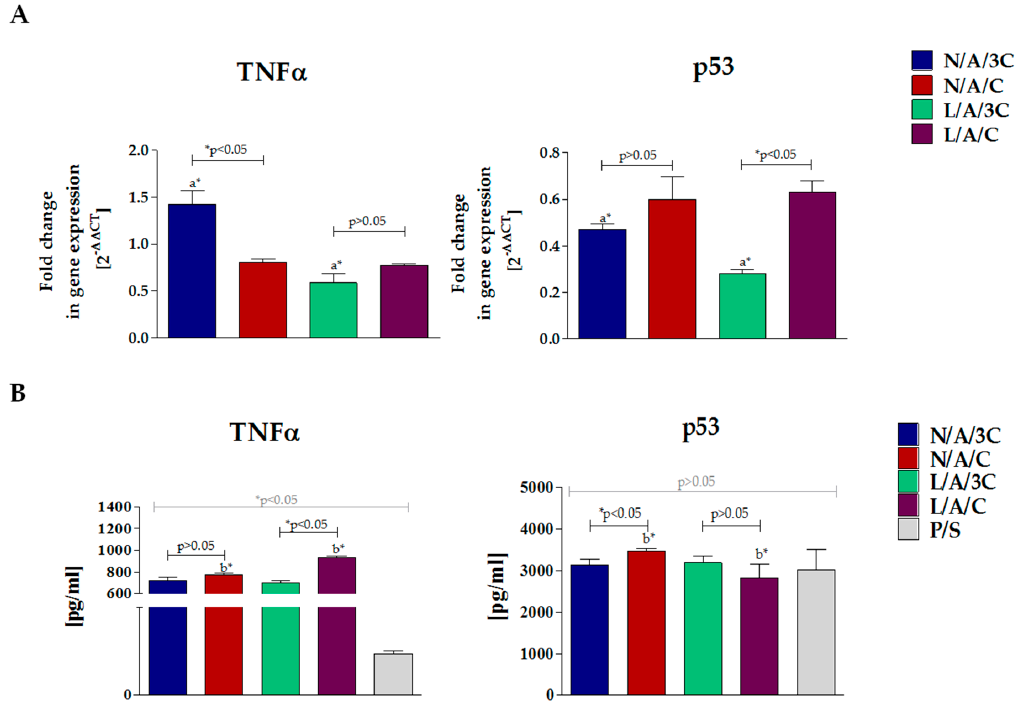
Figure 10. ( A ) Results of analysis of cytokine expression in RAW264.7 cultures with biomaterials. Gene expression of p53 and TNF- α was determined with qPCR, 2 −ΔΔ C t method was used to calculate the quantification of relative values, normalizing data to control and including expression of reference gene ( ACT β ). The secretion of cytokines measured with specific ELISA test ( B ). Error bars represent standard deviation from the mean calculated for normalized values obtained in three separate replicates. An asterisks (*) represent statistically significant differences ( p ˂ 0.05).